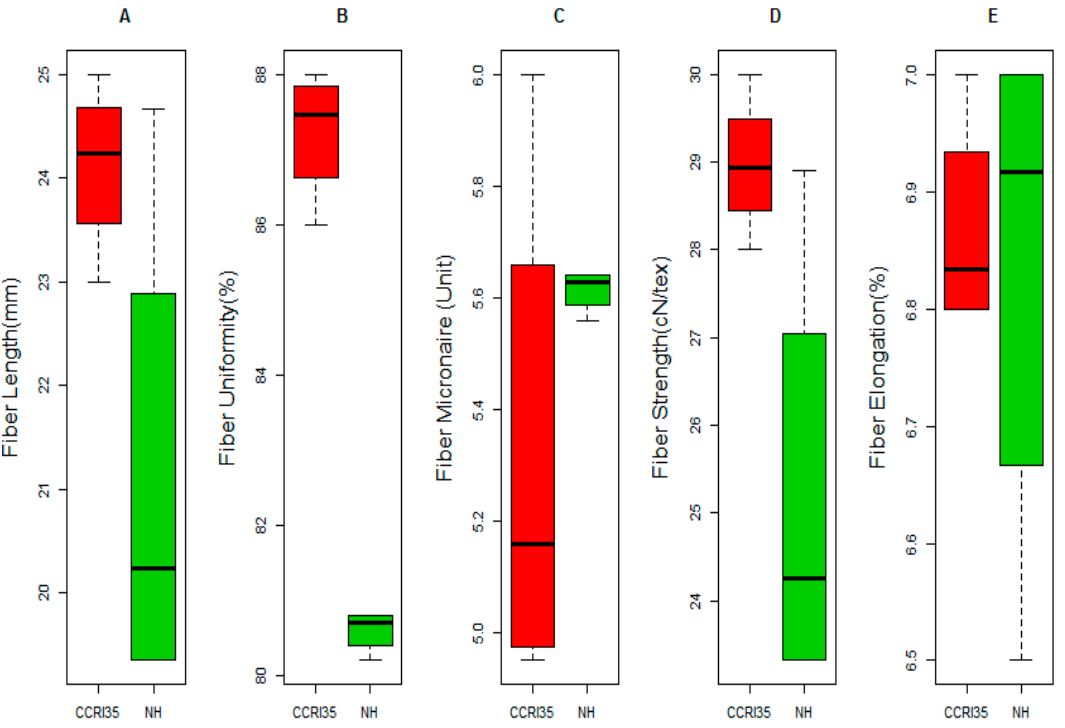
Figure 1. Phenotypic analysis of the two parents for fiber quality and yield-related traits; ( A ) Fiber Length (mm); ( B ) Fiber Uniformity (%); ( C ) Fiber Micronaire (Unit), ( D ) Fiber Strength (cN/tex); ( E ) Fiber Elongation (%).CCRI35: female parent, NH: male parent.